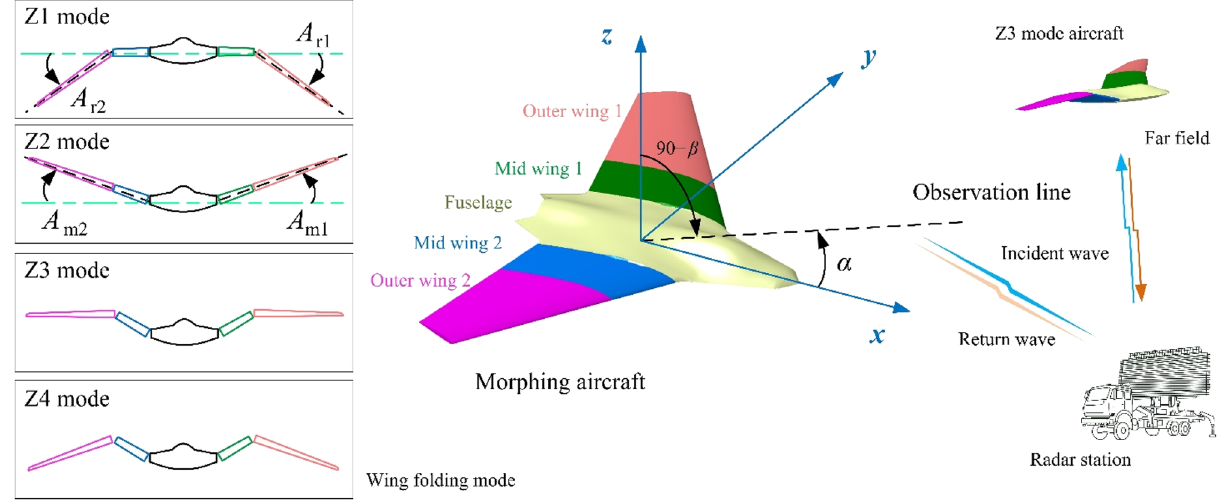
Figure 1. Schematic of dynamic scattering of the morphing aircraft with Z-folding